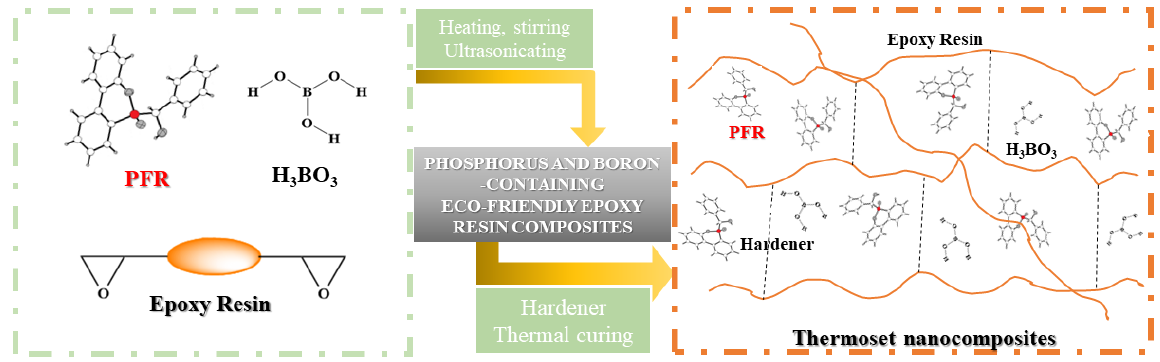
Figure 4. Graphical representation of epoxy composites synthetic pathway.